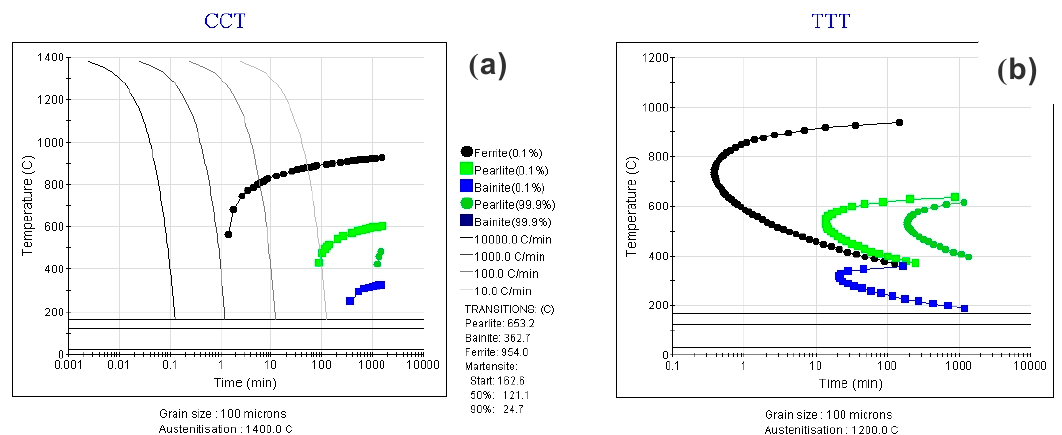
Figure 2. Diagrams simulated by using JMatPro software: ( a ) Transformation diagram in continuous cooling (CCT) and ( b ) time–temperature transformation diagram (TTT).